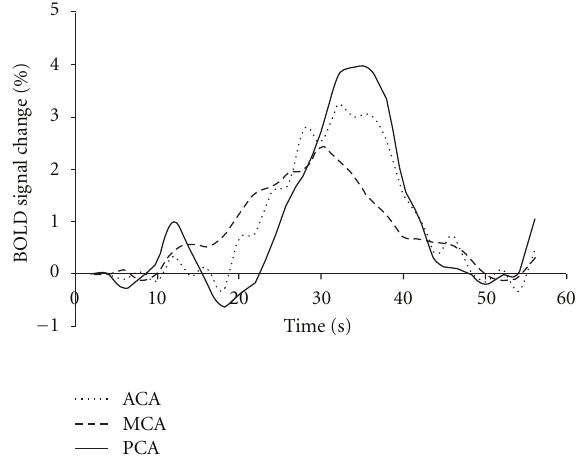
Figure 3: BOLD responses to CO 2 inhalation in brain regions supplied by the three main cerebral arteries (anterior: ACA, middle: MCA, and posterior: PCA), for healthy